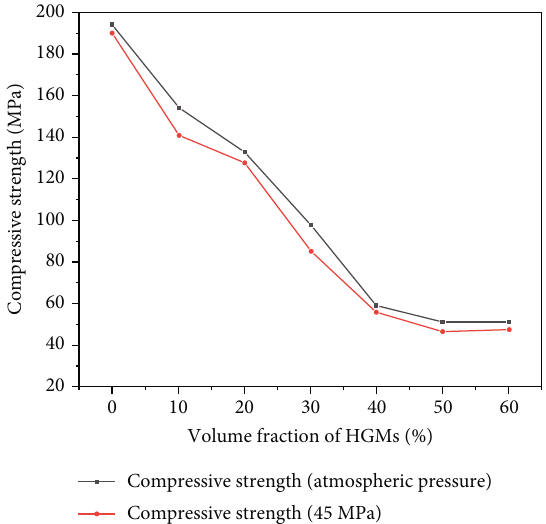
Figure 10: Compressive strength curves of the HGM/EP composite insulation materials.